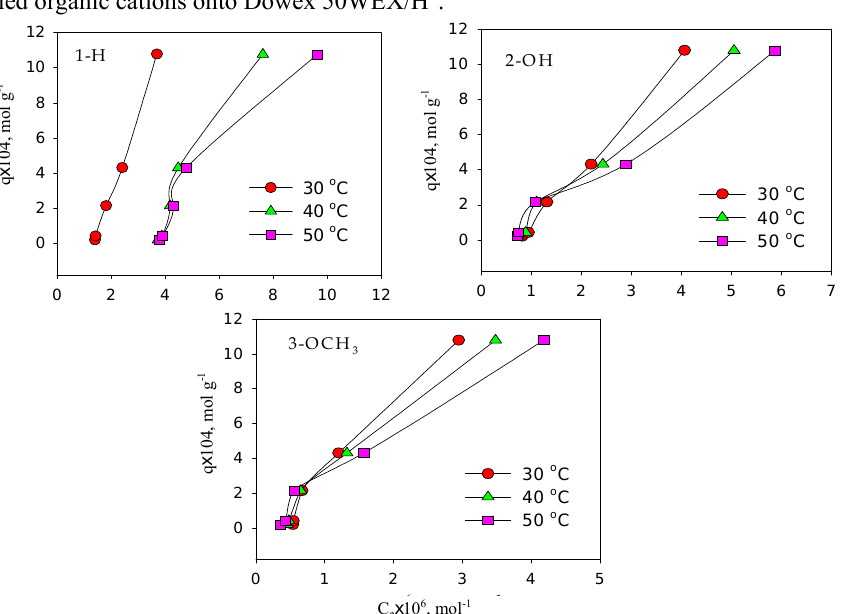
1 for the adsorption of various concentrations of the K ln against d T